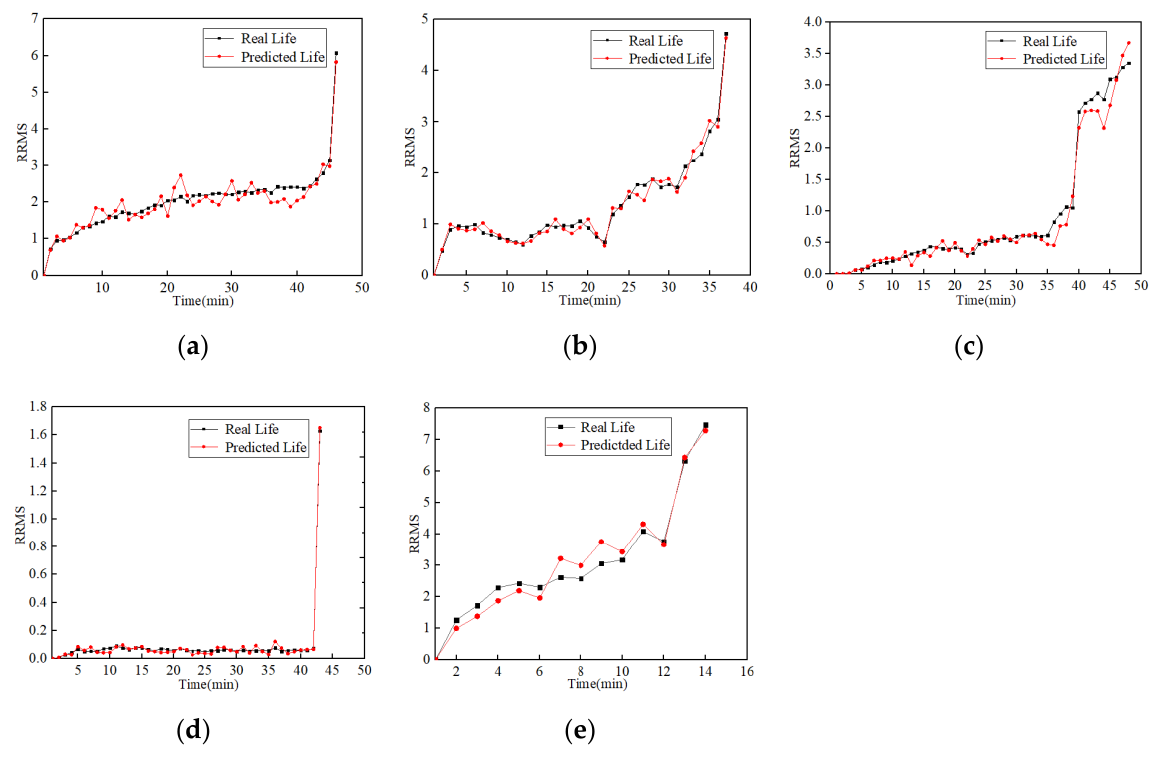
Figure 5. ( a ) RRMS prediction result of bearing1_1; ( b ) RRMS prediction result of bearing1_2; ( c ) RRMS prediction result of bearing1_3; ( d ) RRMS prediction result of bearing1_4; ( e ) RRMS prediction result of